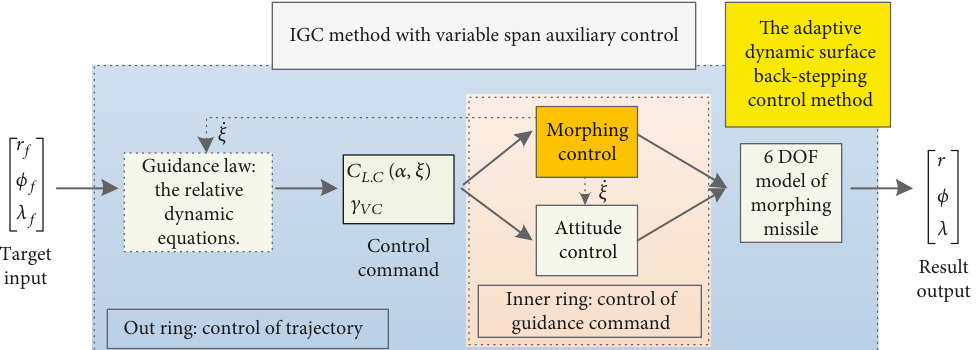
Figure 4: The roadmap of the IGC method with variable span auxiliary control.